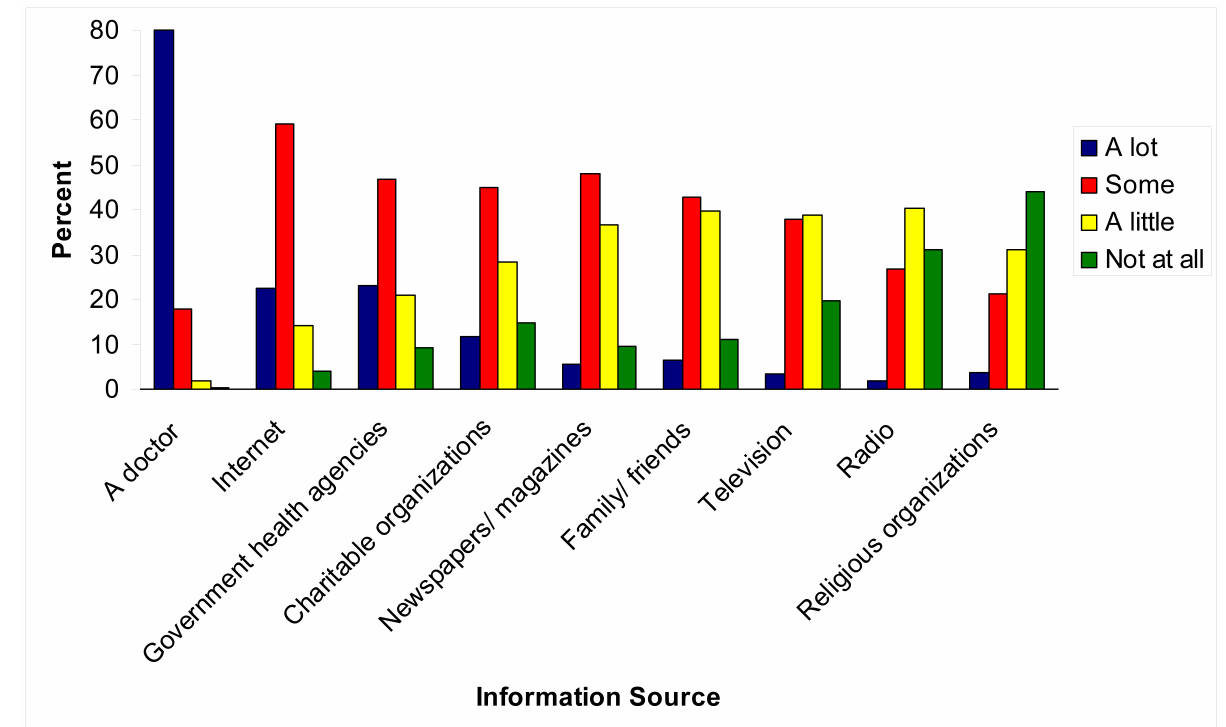
Figure 1. Degree of trust in various information